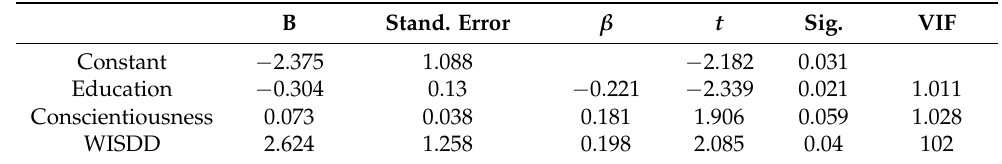
Table 4. Regression model with Punitive attitude as dependent variable. B Stand.